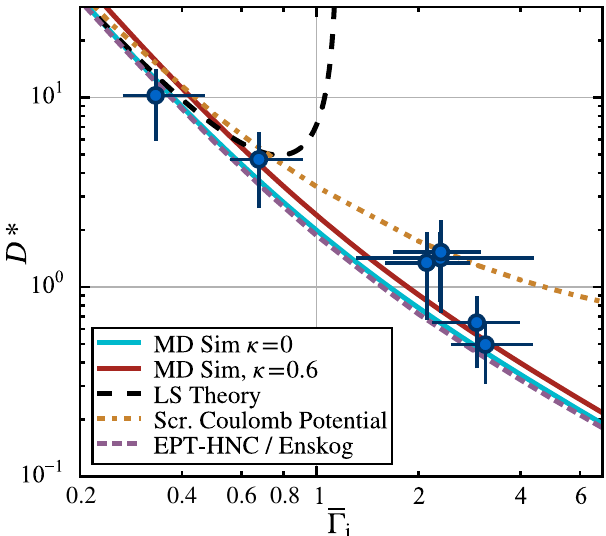
FIG. 5. Plot of the normalized self-diffusion coefficient D (cid:3) [Eq. 7)] calculated for our data. The solid blue and solid red lines represent results from MD simulations for κ ¼ 0 and κ ¼ 0 . 6 , respectively [5,6]. The black dashed line represents the Landau- Spitzer (LS) theory for weakly coupled plasmas, which diverges in the regime of strong coupling. The orange and the purple dashed lines use screened Coulomb and hypernetted chain interactions, respectively, as described in the